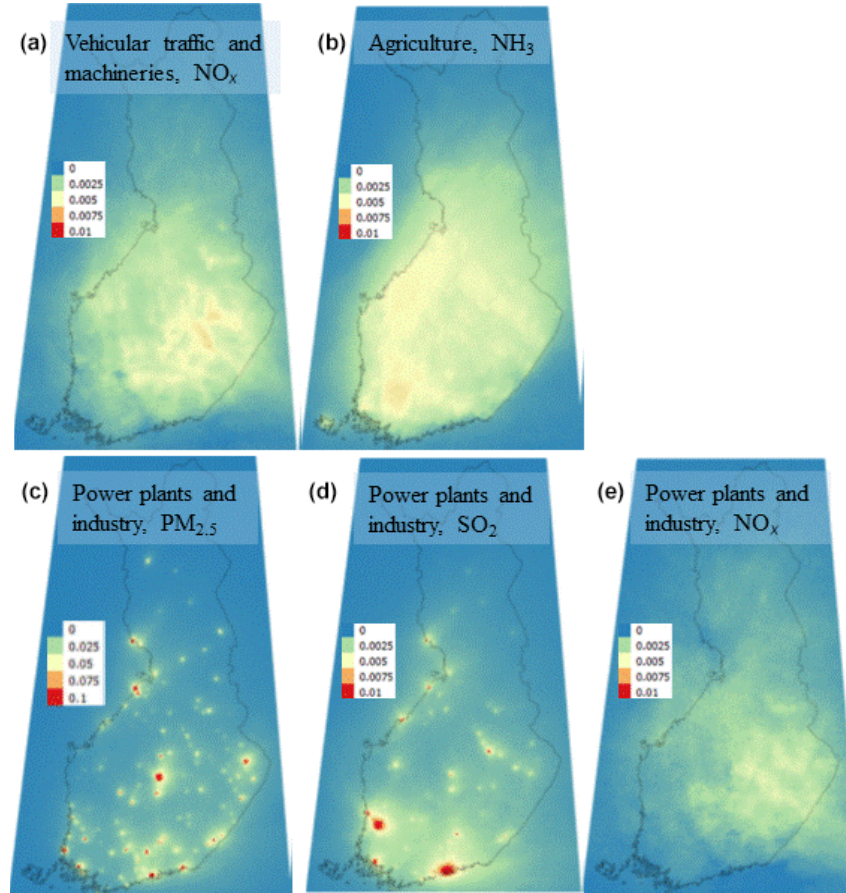
Figure 4. The reductions in concentrations of PM 2 . 5 (ngm − 3 ), caused by a reduction in emissions of 1t of corresponding pollutants origi- nating from three source categories. The panels present the decrease in concentrations due to reductions in the following emissions: (a) NO x originating from vehicular traffic and machineries, (b) NH 3 originating from agriculture, (c) PM 2 . 5 originating from power plants and in- dustry, (d) SO 2 originating from power plants and industry, and (e) NO x originating from power plants and industry. The spatial resolution is 5 × 5km 2 . The scale of reductions is different for (c)